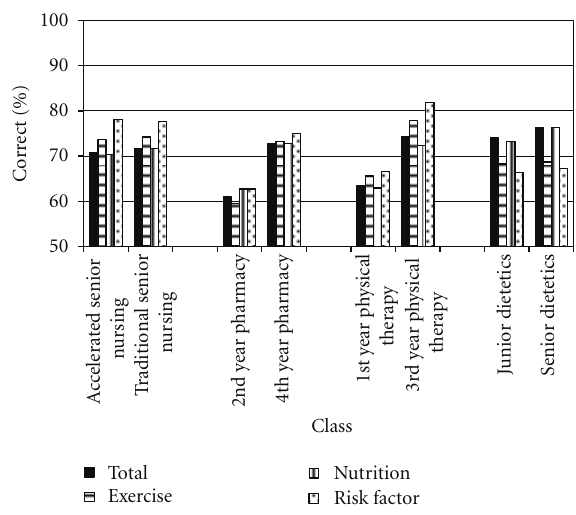
Figure 1: Percent correct for total and subscales by